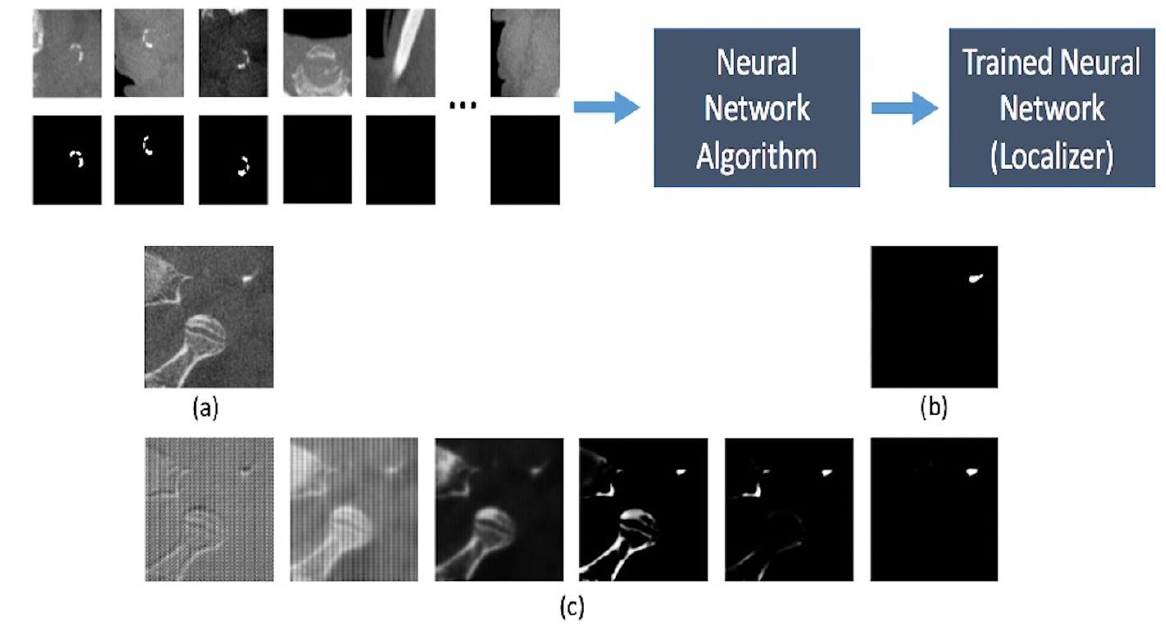
Figure 6. A sample of how the neural network iteratively trains itself. ( a ) an image that the neural network is trying to learn how to analyze. ( b ) the mask created by the radiologist. ( c ) from left to right, demonstrates the neural network getting more accurate in localizing the calcification after being trained on progressively more data.